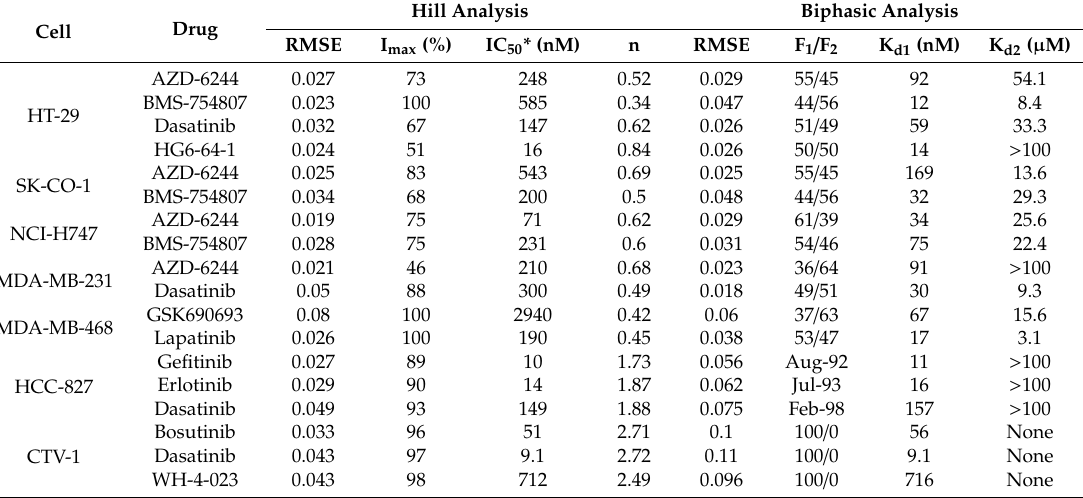
Table 2. Analysis of cancer cell response to kinase inhibitors by the Hill equation and the biphasic mathematical model. The data used for the analyses are derived from the current study and two previous studies [12,47], and the data are provided in Supplementary Data for Table 2. An example of Hill and biphasic analyses (the e ff ect of dasatinib on MDA-MB-231) is shown in Supplementary Data—Hill and Biphasic Analyses of the E ff ects of Dasatinib on